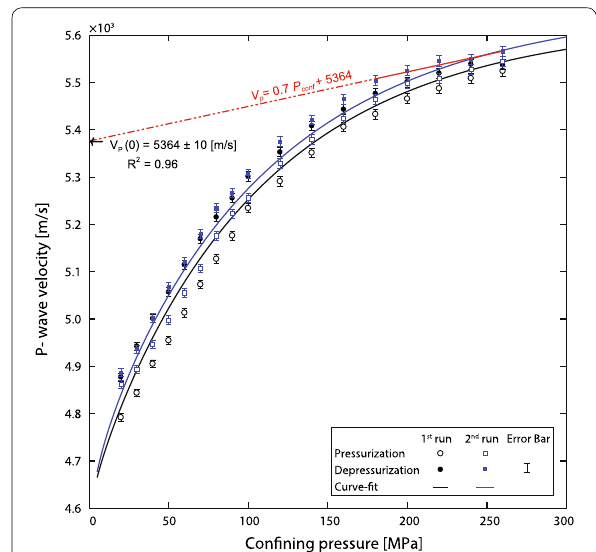
Fig. 8 Example of two cycles of pressurization–depressurization of compressional-waves (sample HU25X). The non-linear velocity/ pressure correlation at low pressure (up to ca. 175 MPa) is due to the closure of cracks/pores. The linear velocity/pressure correlation is due to intrinsic compressibility elastic moduli of the mineral skeleton of the rock. The velocity measurements during the depressurization run (filled symbols) show larger values than those obtained during the pressurization runs (empty symbols). This effect (hysteresis) is interpreted as due to the only partial re-opening of fractures and microcracks that close during pressurization. The intrinsic velocity V p ( 0 ) was calculated by the linear regression (red line) intersection of the high-pressure part of the second depressurization 2nd run back to the zero-confining pressure. These coefficients of the linear regression are corresponding to the pressure derivative of velocities. The fitting curve was calculated on the 2nd complete run using the Wepfer and Christensen (1991)